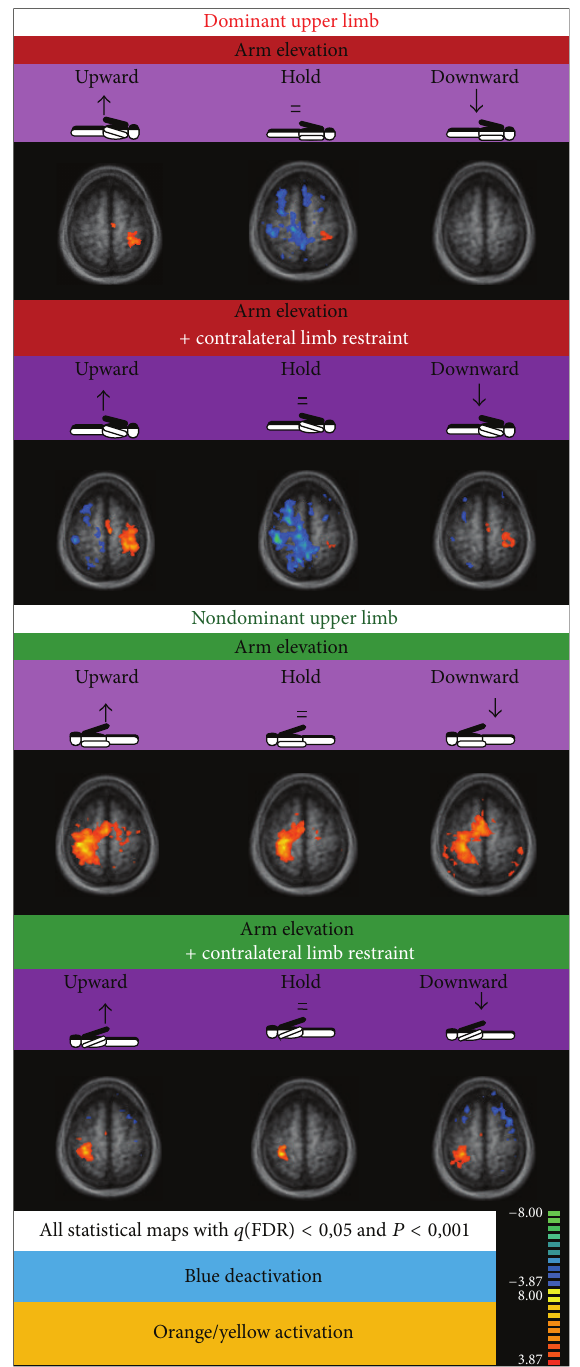
Figure 3: Statistical maps for tasks involving elevation coupled or not with restraint of dominant and nondominant upper limbs ( 𝑛 = 17 , RFX , 𝑃 (corrected) < 0,001